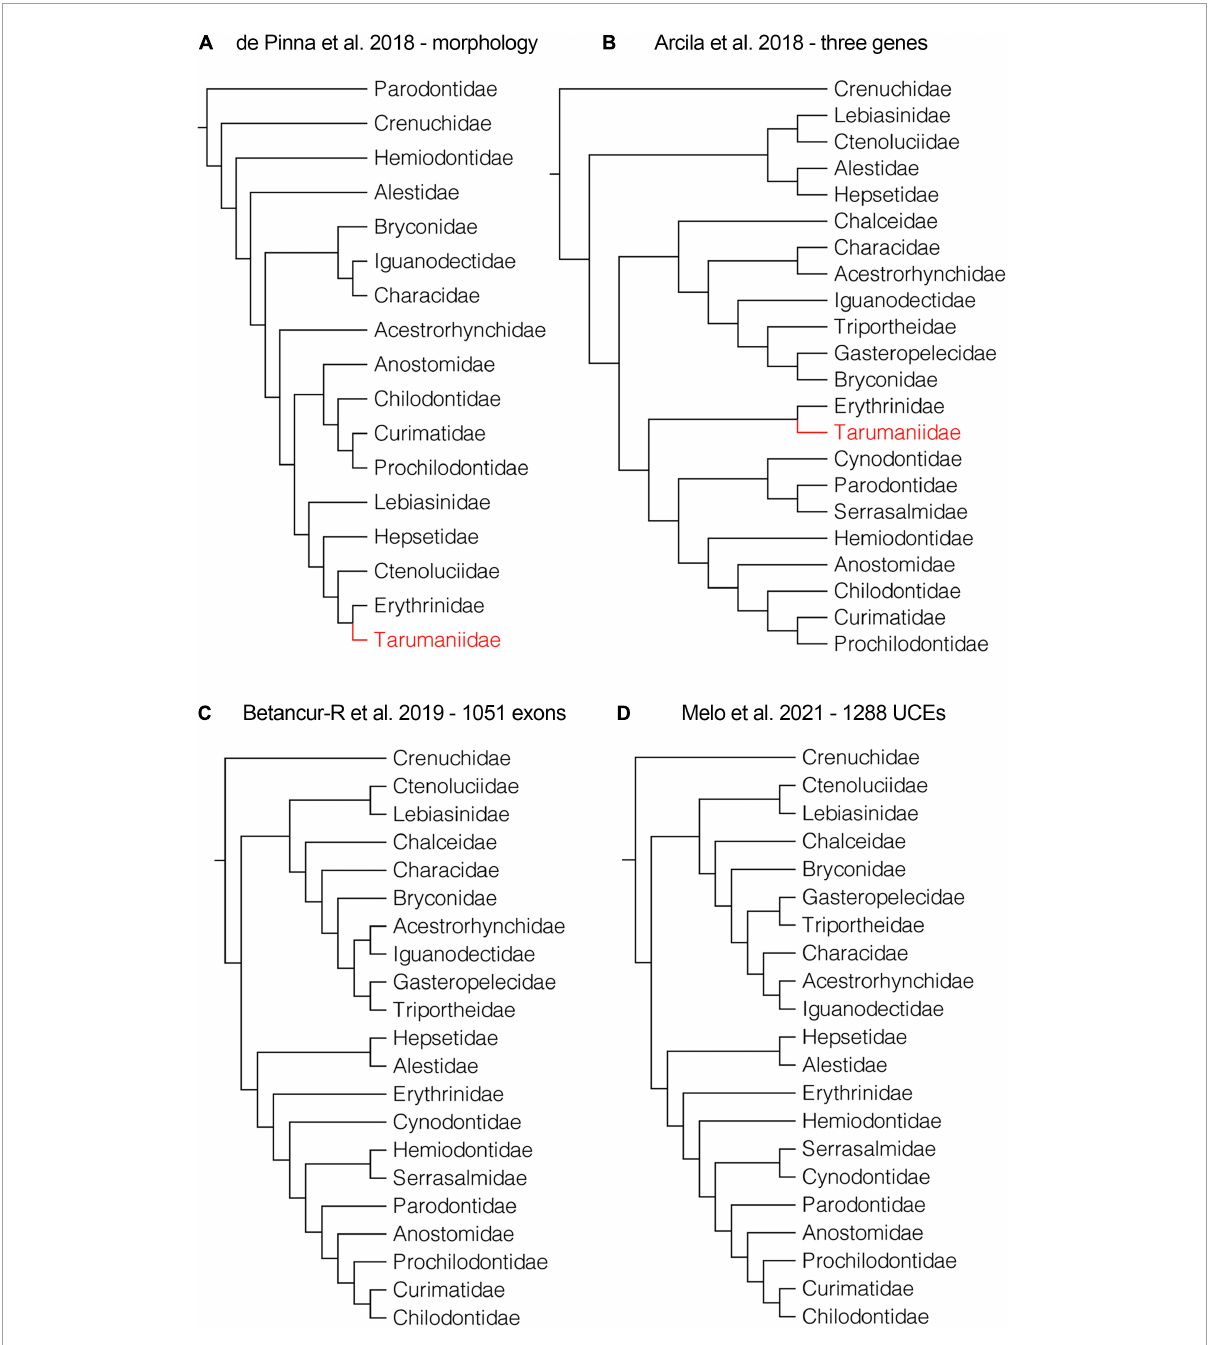
FIGURE2 Alternative hypotheses for interfamilial relationships in Characiformes based on distinct sources of characters: (A) Morphological dataset with 128 characters and 33 taxa (de Pinna et al., 2018); (B) Molecular dataset of 12S , 16S , and Rag1 genes and 520 taxa (Arcila et al., 2018); (C) Molecular dataset of 1,051 exons and 321 taxa (Betancur-R et al., 2019); (D) Molecular dataset of 1,288 ultraconserved elements (UCEs) and 356 taxa (Melo et al., 2022). Note the lack of Tarumaniidae in the two phylogenomic studies (C,D)